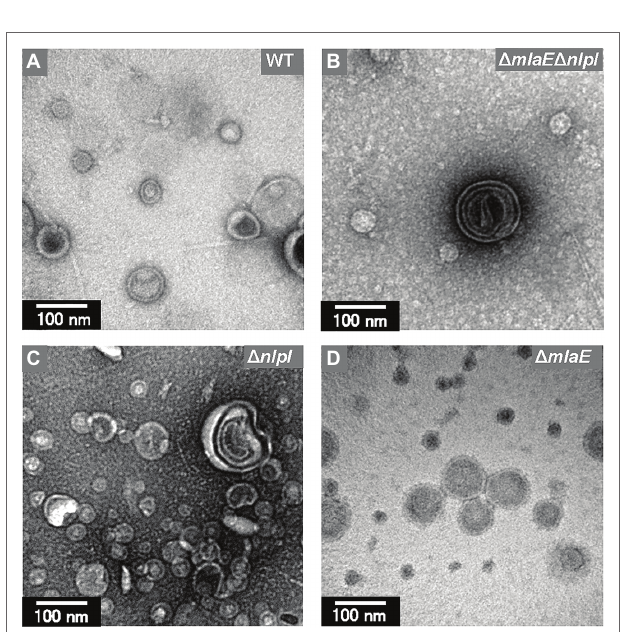
FIGURE 5 | Transmission electron microscopy (TEM) images of the OMVs isolated from E. coli . (A) WT. (B) Δ mlaE Δ nlpI . (C) Δ nlpI . (D) Δ mlaE strains. The OMVs were stained with uranyl